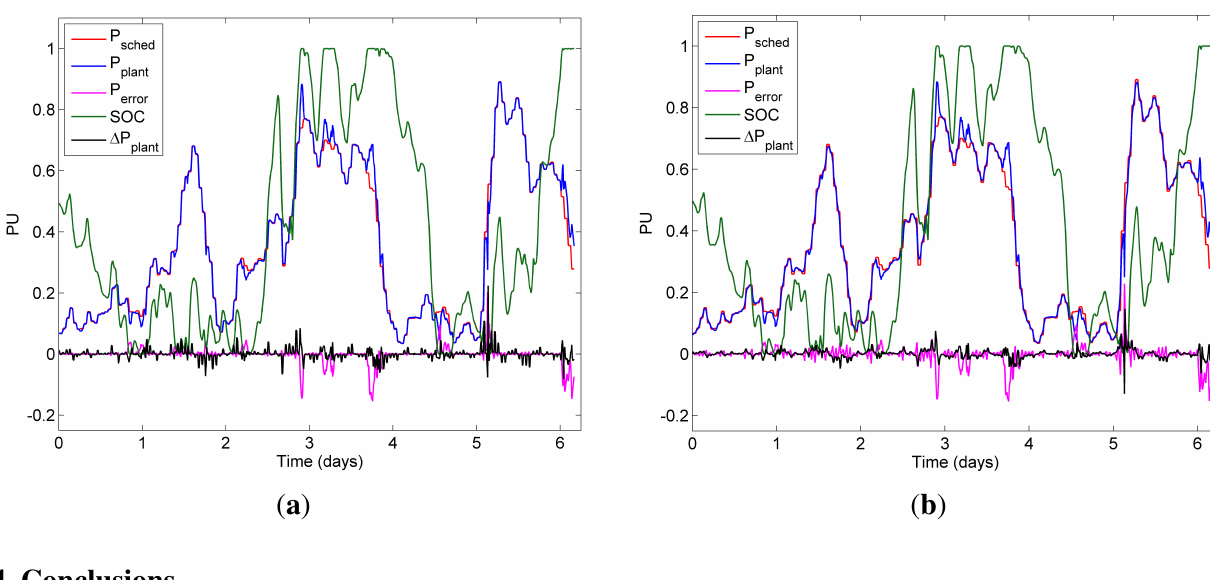
Simulation results for: ( a ) Case 7 with combined error reduction and ramp reduction, with a ramp cost of 600 $/PU 2 ; and ( b ) Case 8 with combined error reduction and ramp reduction, with a ramp cost of 6000 $/PU 2 . As shown in Table 2, the ramp events are greatly reduced with a minimal increase in P err